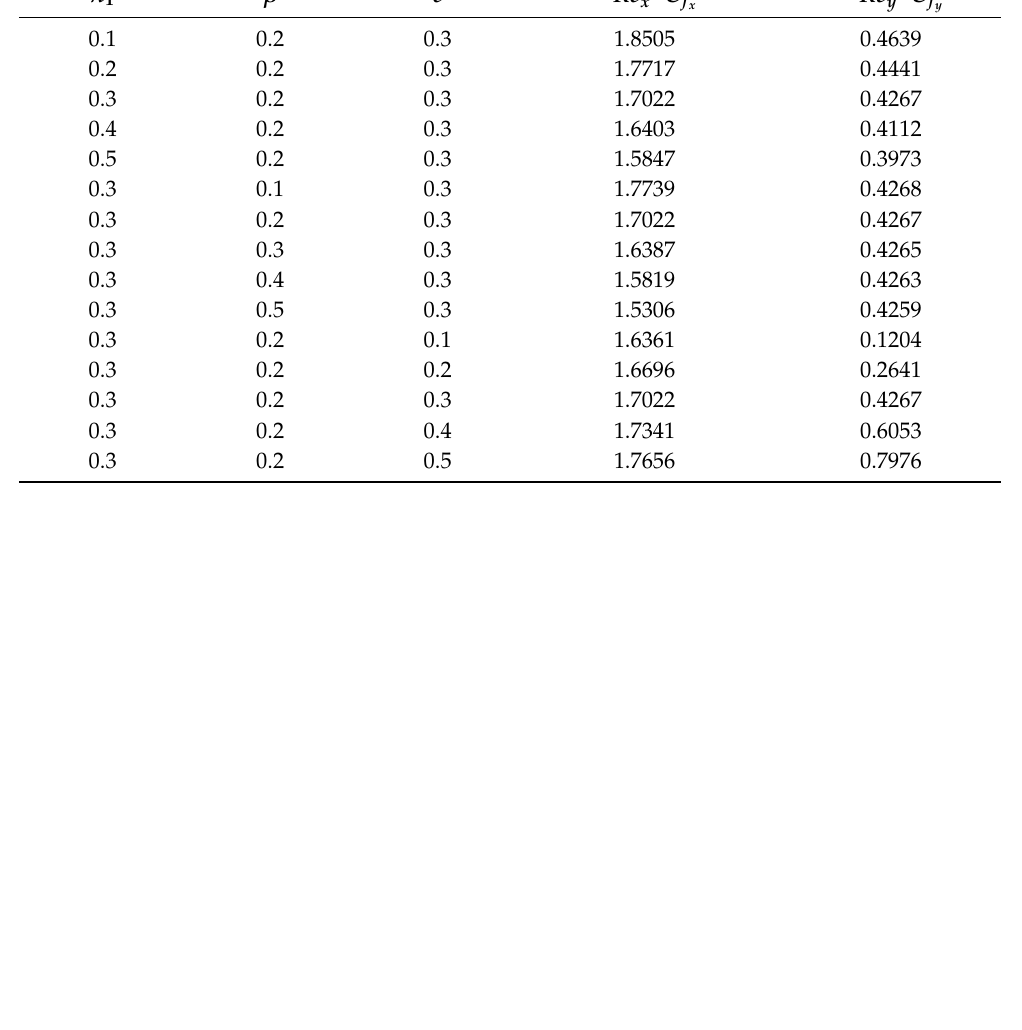
( 0 ) for α = 0.3, β = 0.2, 4